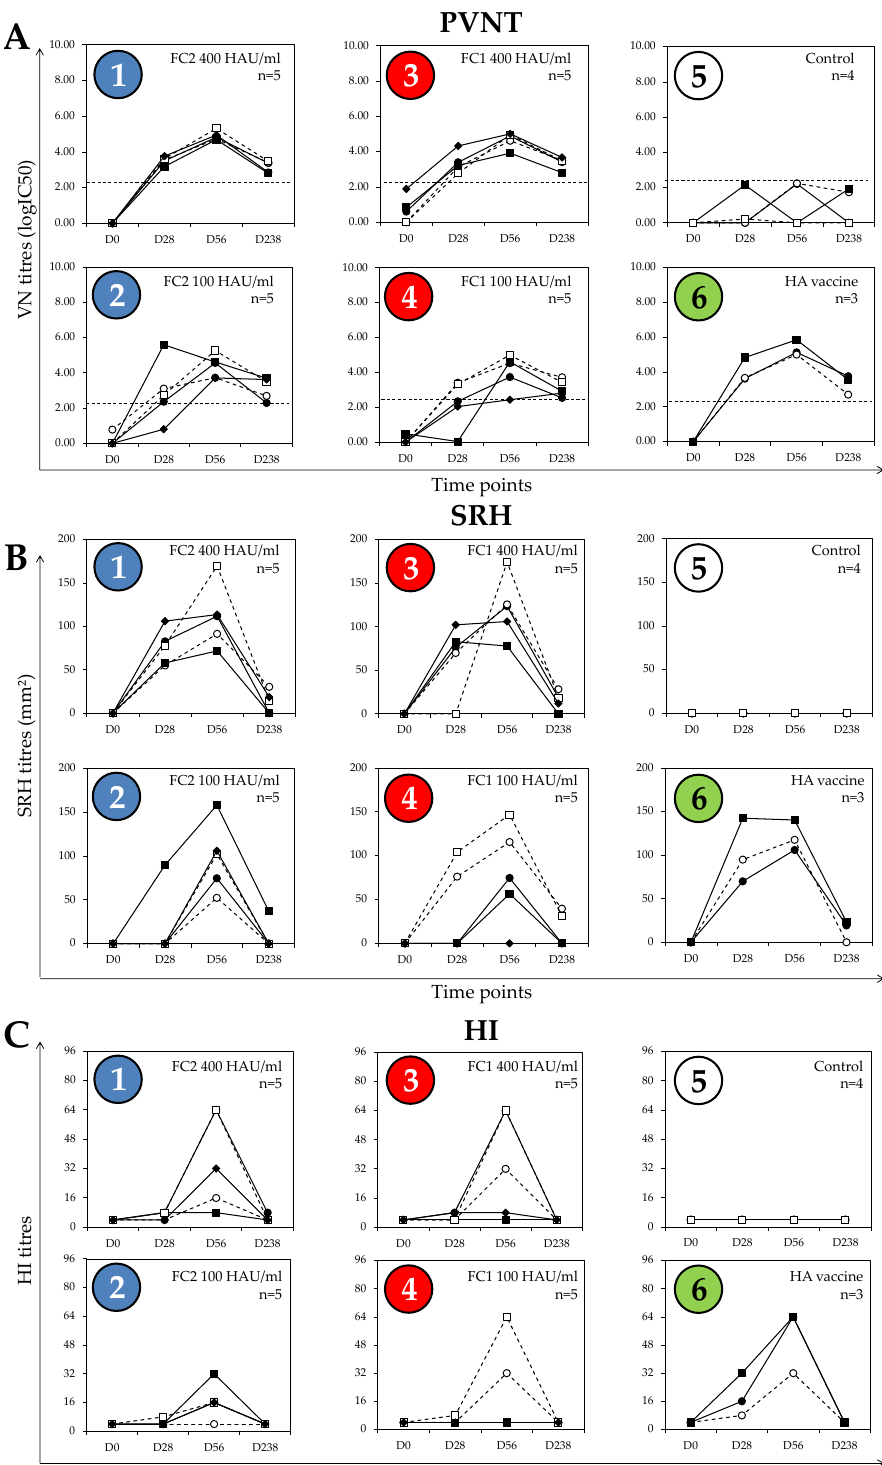
Figure 2. Serum set #1 antibody response kinetics per group, measured by ( A ) pseudotype virus neutralization test (PVNT), ( B ) single radial haemolysis (SRH), and ( C ) hemaglutination inhibition (HI) assays. The dotted line represents the calculated positive threshold (2.21 logIC50) for the PVNT. The number of ponies per group is indicated ( n ). D values indicate days after immunization. HAU / mL = HA unit per mL. Groups 1 and 2 are indicated in blue, groups 3 and 4 are indicated in red, and the control group 5 and HA vaccine group 6 are indicated in white and green,